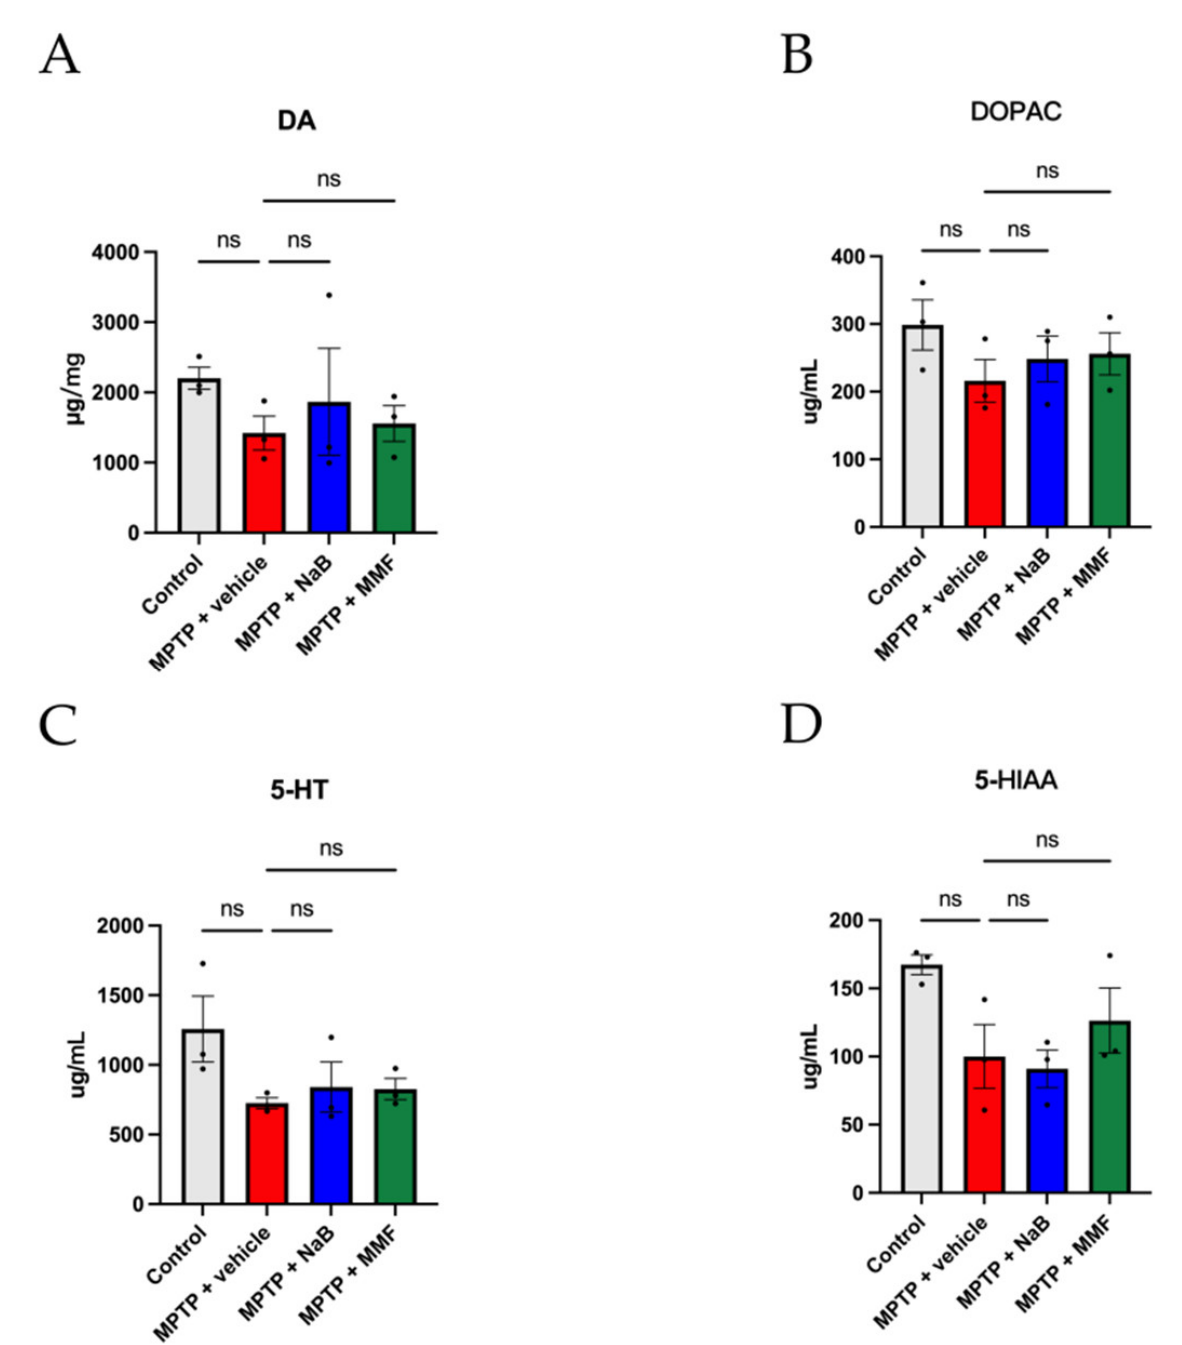
Figure 4. NaB and MMF treatment alleviates the reduction of brain neurotransmitters in MPTP- induced PD mice. ( A ) When compared to the MPTP + vehicle group, both the MPTP + NaB group